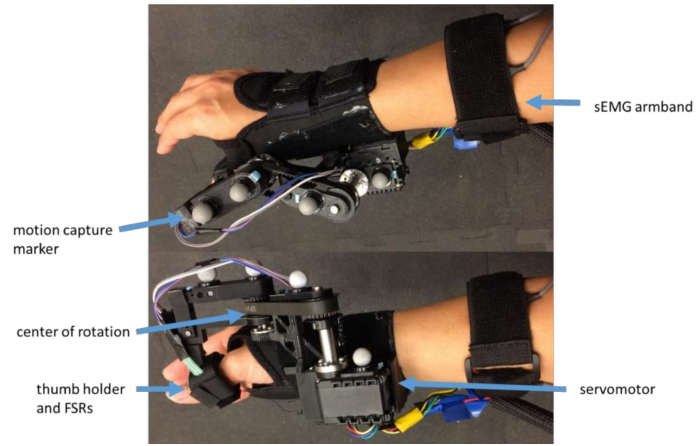
Figure 1. ILEXOS thumb exoskeleton from the top and side. Force-sensitive resistors (FSRs) are located on either side of the thumb (slightly offset from palmar and dorsal surfaces), between the user and the exoskeleton. The center of rotation is positioned near the carpometacarpal joint. Positioning of the entire exoskeleton as well as segment lengths can be adjusted via Velcro and set